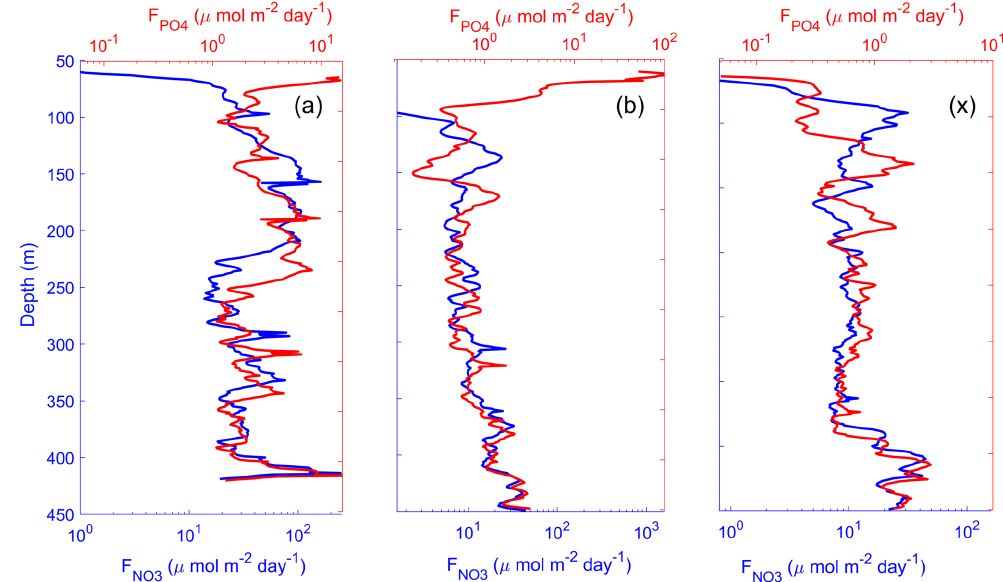
Figure 14. Time average of vertical profiles of nitrate and phosphate turbulent diffusive fluxes at long-duration stations LD-A (a) , LD-B (b) , and LD-C (c) . The scales of the nitrate and phosphate diffusive flux are set to match with the typical Redfield ratio ( N : P = 16 :